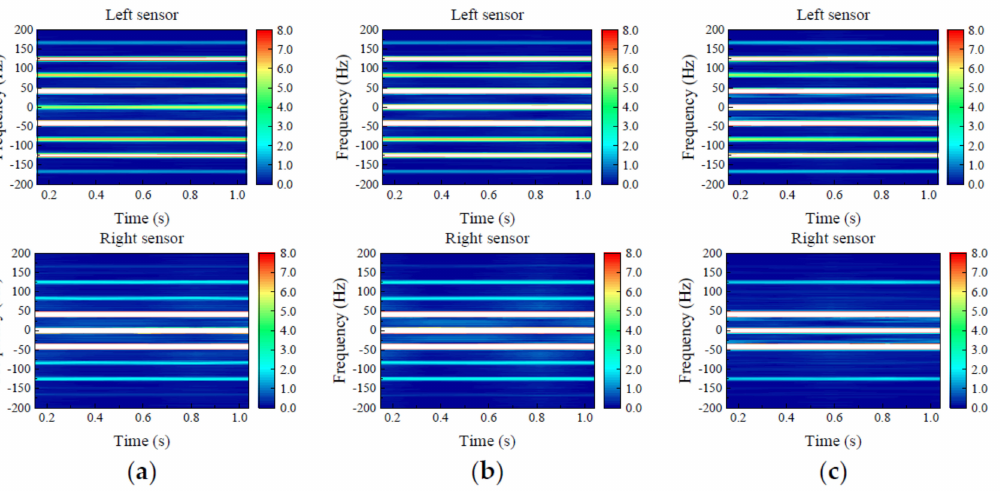
Figure 24. Time-frequency diagram of misaligned faults: ( a ) value of imbalance 2.5 × 10 − 5 kg ·